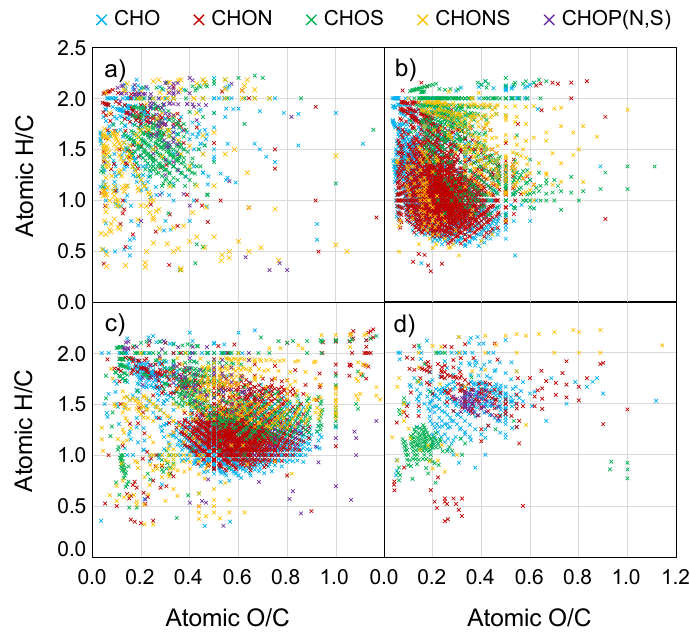
Figure 3. Van Krevelen diagrams for molecular formulas identified by PCA for ( a ) marine; ( b ) biomass